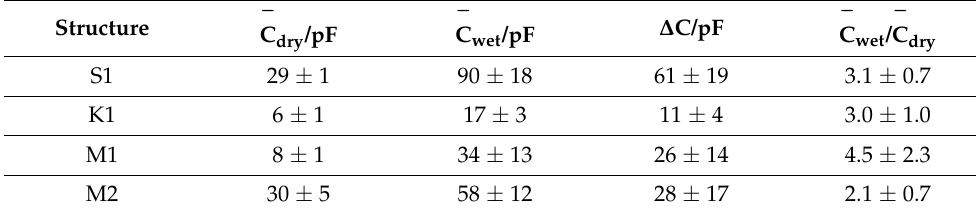
Table 3. Mean capacitances ((C = ( C max − C min ) /2), the difference in electrical capacitances in moist (wet) and dry (dry) states ∆ C (= C wet − C dry ), and the relative capacitance changes (C wet /C dry ) of the four sensor structures (three to five measurements each). The structures were dry or moistened by spraying with water.